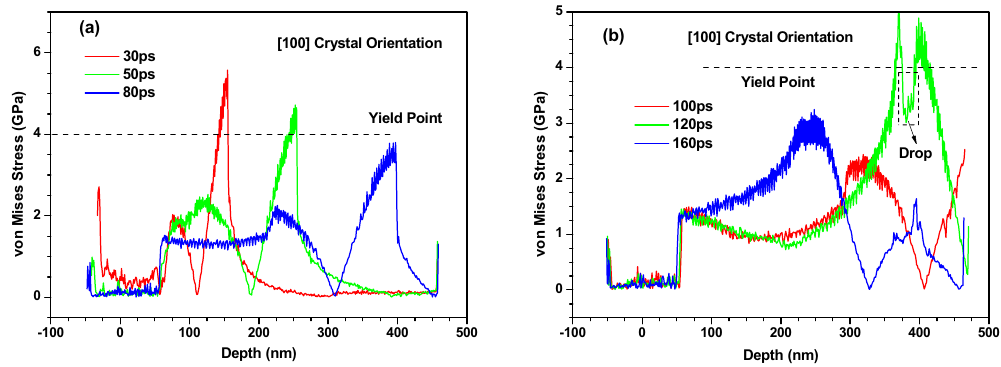
Figure 10. Equivalent stress (von Mises) distribution of 450 nm 〈 100 〉 copper films under an absorbed laser intensity of 0.065 J/cm 2 at 30–160 ps time